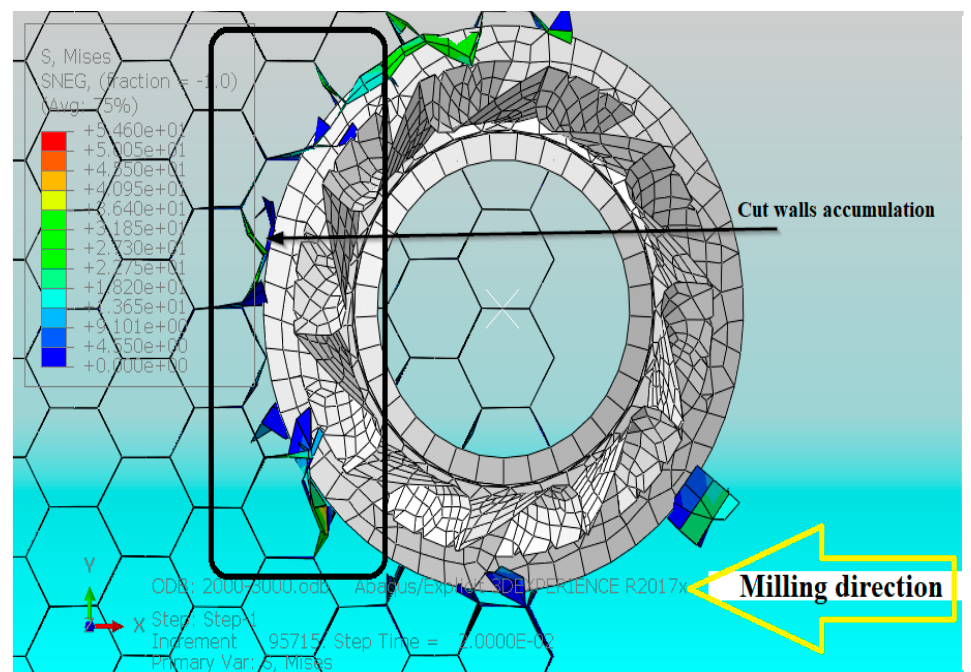
Figure 21. Accrual of material in the face of the cutting tool; wedge angle of the cutting blade is β n = 15°.